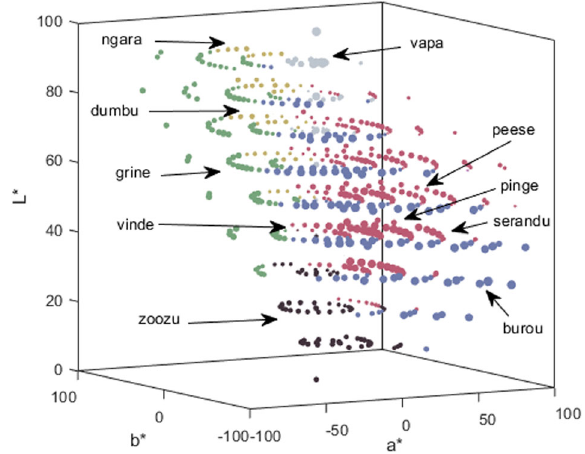
Fig. 2 Modal terms in Himba (serandu, n = 219; burou, n = 131; grine, n = 98; zoozu, n = 69; dumbu, n = 42; vapa, n = 35; ngara, n = 3; vinde, n = 1; pinge, n = 1; peese, n = 1). Disc size corresponds to the peak of the conditional probability P ( n | c ) that colour name n was used for each colour c . The colour of each disc corresponds to the centroid of each colour